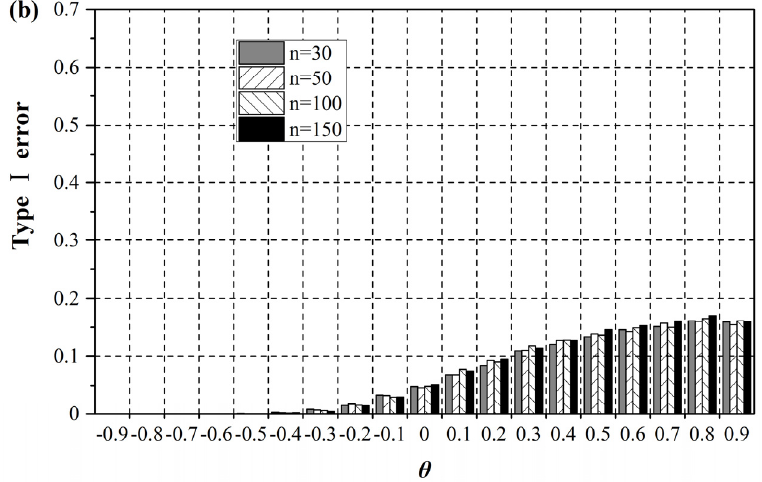
Figure 1. The effect of autocorrelation on Type І errors (10,000 simulated sample series): ( a ) AR(1); ( b ) MA(1).